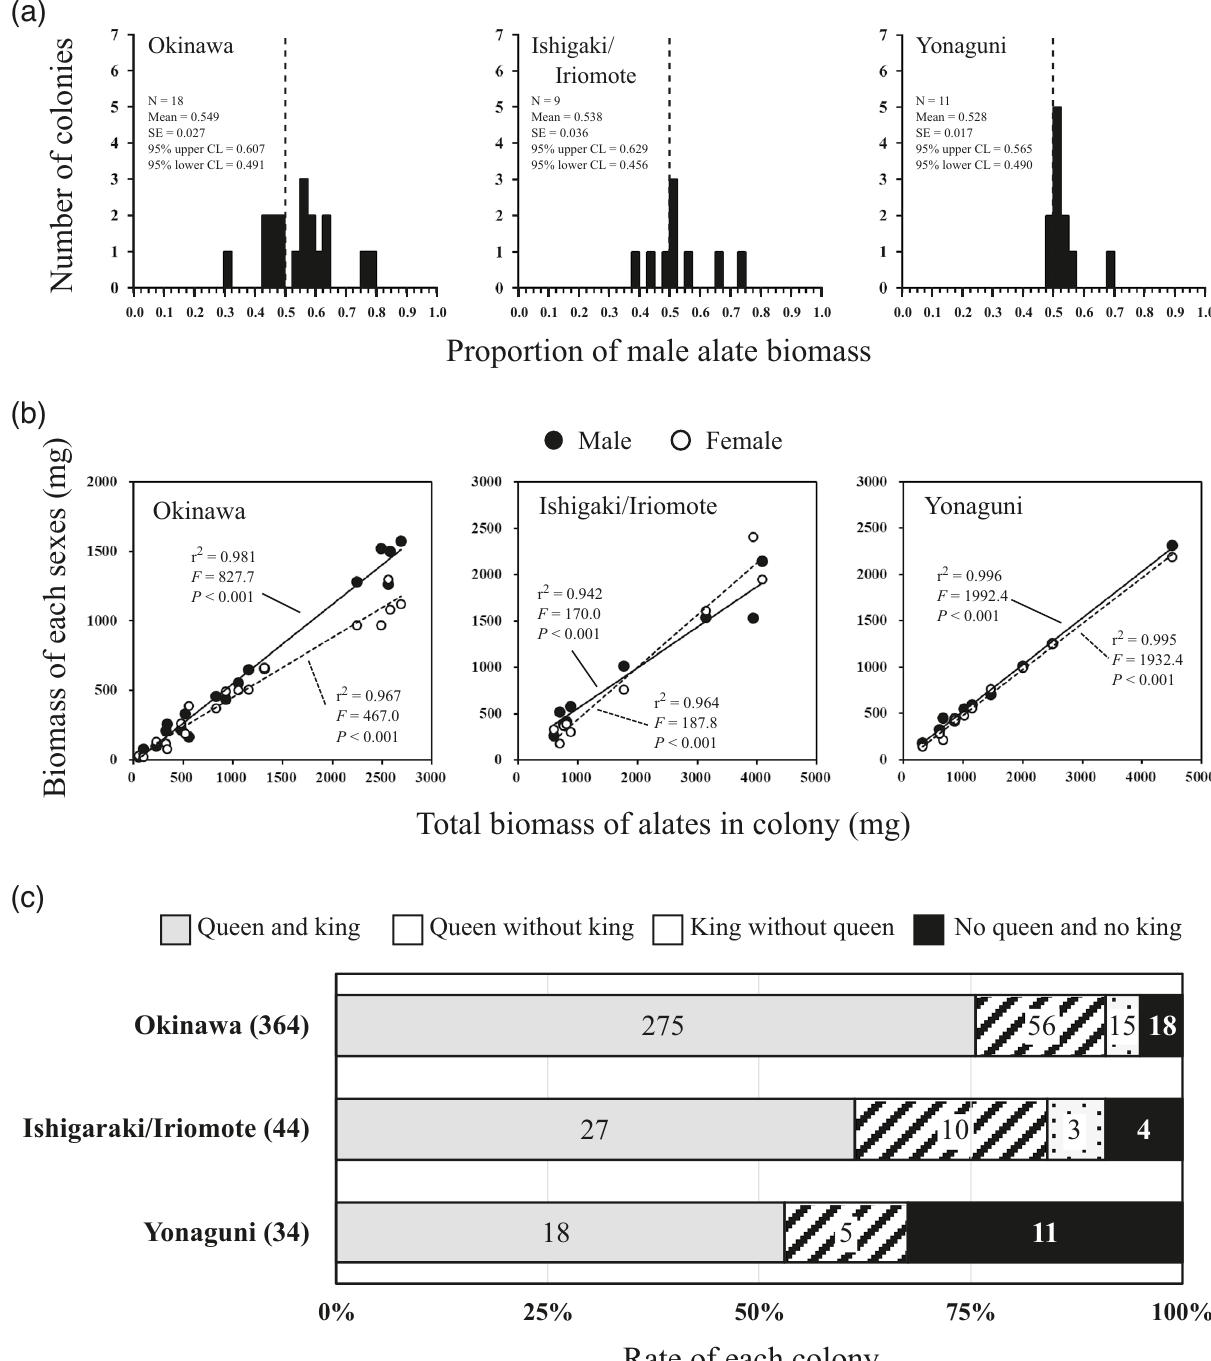
Figure 2. Characteristics of sex allocation and results of the test for intrasexual competition among siblings (ICS) and sex-asymmetric longevity corresponding to sex-asymmetric reproductive value (SRV) in the three populations. ( a ) Histogram of the proportion of biomass of male alates in the colonies of the three populations. ( b ) Plot analysis of the model of ICS. ( c ) Pattern-frequency of reproductives in the three populations. Solid lines (males) and dashed lines (females) in ( b ) show the correlations between the total biomass of alates in a colony and the biomass of alates of each sex in a colony, and numerals on the graph ( c ) indicate the number of colonies. CI confidence